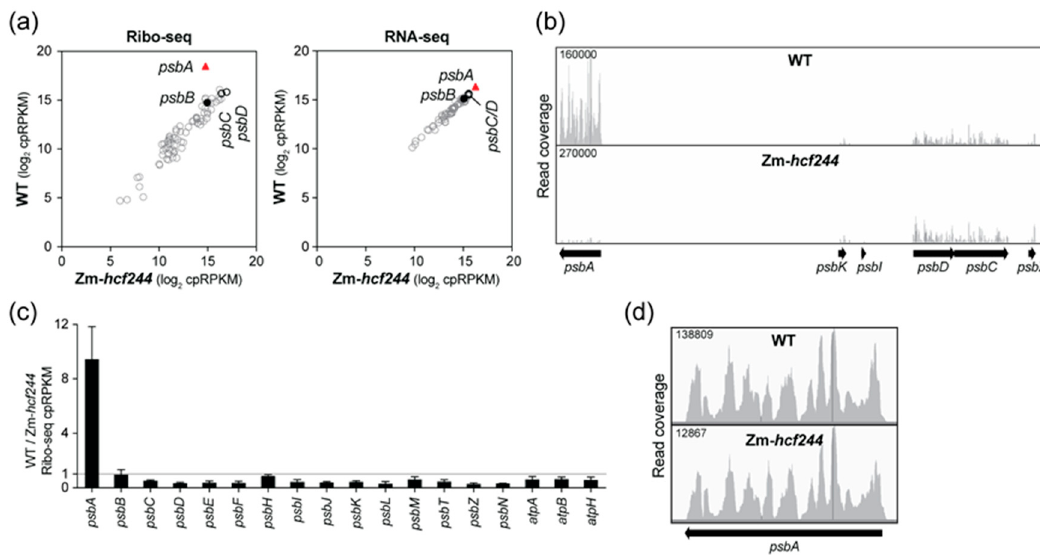
Figure 2. Analysis of chloroplast gene expression in the Zm- hcf244 mutant by Ribo-seq and RNA-seq. Results from a replicate experiment are shown in Figure S1a. ( a ) Comparison of ribosome footprint abundance (Ribo-seq) and RNA abundance (RNA-seq) for all chloroplast genes in the Zm- hcf244 mutant and its phenotypically-normal sibling (WT). Each symbol represents one gene. Values are expressed as reads per kilobase in the ORF per million reads mapped to chloroplast ORFs (cpRPKM). ( b ) Screen capture from the Integrated Genome Viewer (IGV) showing the distribution of ribosome footprints along psbA and adjacent ORFs in the wild-type and Zm- hcf244 mutant. The Y-axis shows the number of reads at each position (not normalized); the maximum Y-axis values are shown in the upper left, and were chosen such that peak heights in psbD and psbC were similar in the two samples. ( c ) Ratio of Ribo-seq reads in the wild-type relative to the mutant for chloroplast genes encoding PSII subunits. Several atp genes are shown for comparison. The average of the two replicates ( +/ – SD) is shown. ( d ) Distribution of ribosome footprints along the psbA ORF. The Y-axis maxima were adjusted to facilitate comparison of ribosome distributions in the two genotypes.